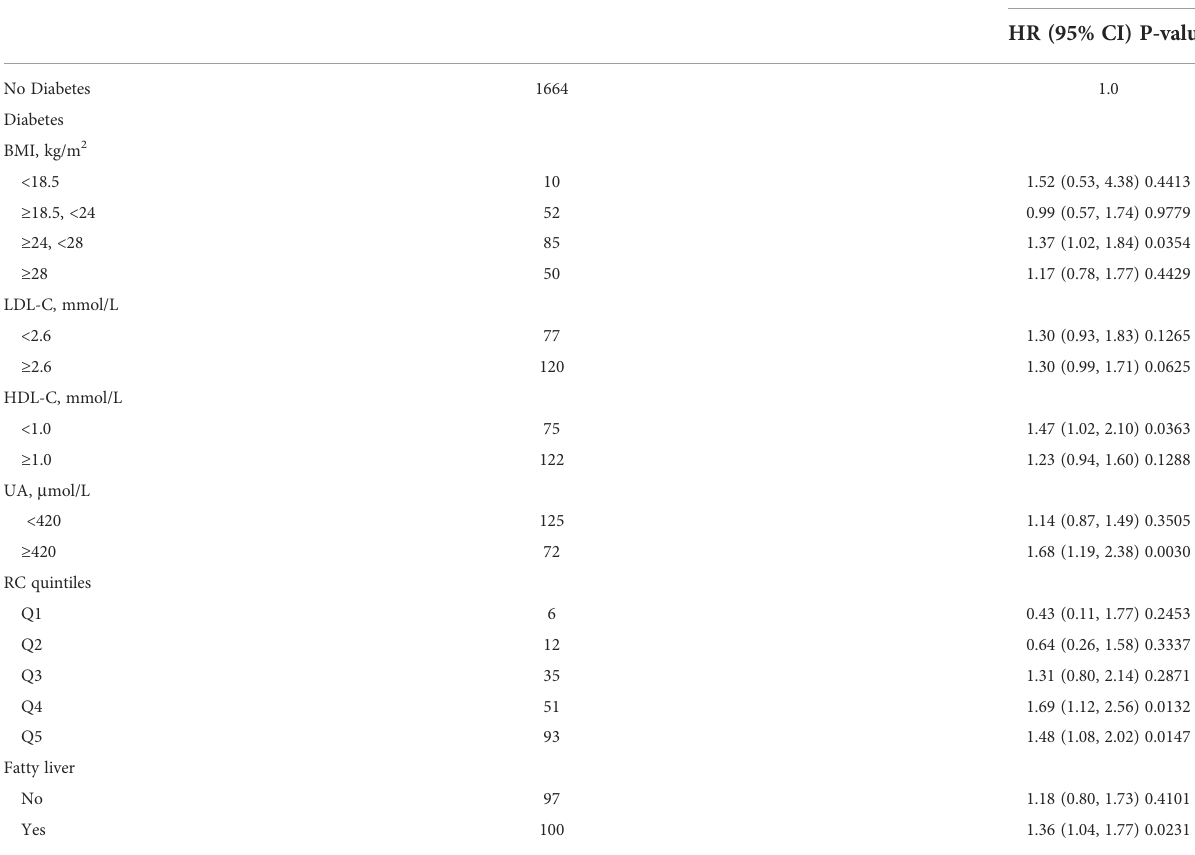
TABLE 5 Associations of risk factors and HTN among participants with diabetes compared with those without diabetes.